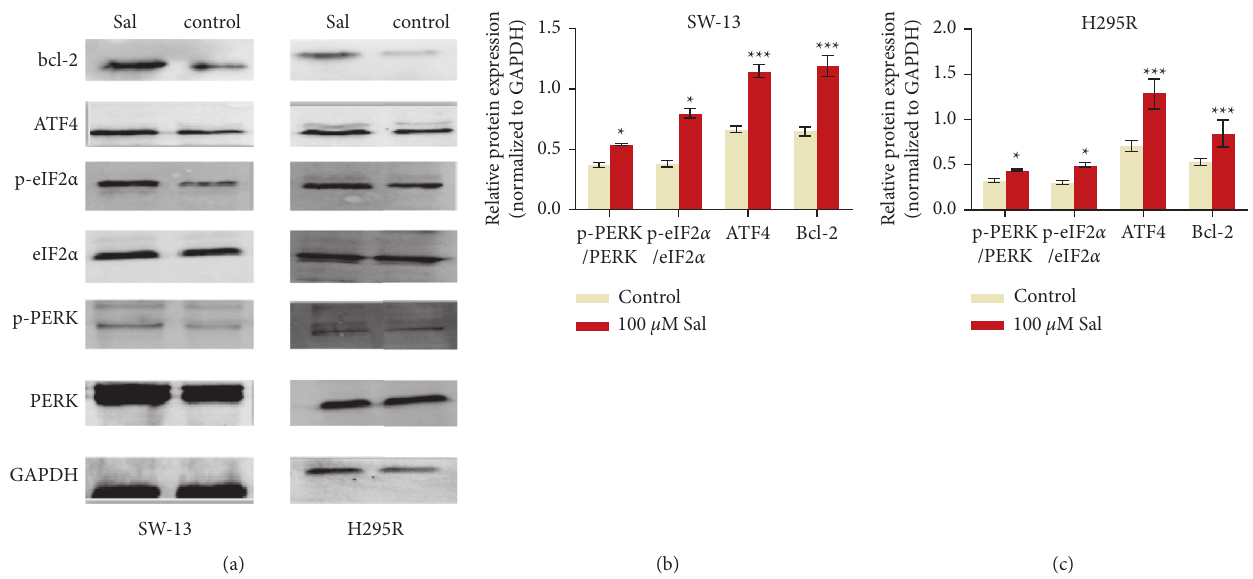
Figure 5: Effect of Sal in the expression of apoptotic and PERK/eIF2 α signaling-related proteins. (a) Expression of Bcl-2 and the PERK/ eIF2 α signaling-related proteins PERK, p-PERK, eIF2 α , p-eIF2 α , ATF4 in SW-13 and NCI-H295 R cells, after treatment with 100 μ m of Sal or not for 24h. (b, c) Quantification of the expression levels of Bcl-2 and the PERK/eIF2 α signaling-related proteins PERK, p-PERK, eIF2 α , p-eIF2 α , and ATF4 in A. The data are expressed as means ± SD ( n � 3). ∗ p < 0 . 05, ∗∗ p < 0 . 001, and ∗∗∗ p < 0 . 001 compared with control